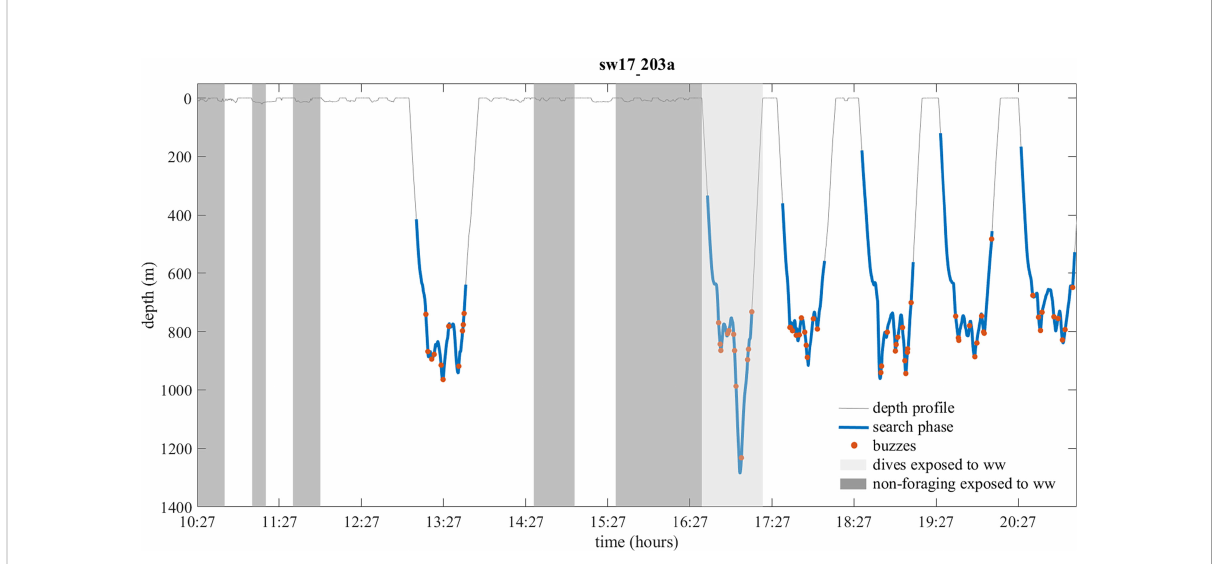
FIGURE 2 Dive pro fi le (thin grey line) of tagged whale sw17_203a with its echolocation behavior (search phase – blue thick segments; buzzes – red circles) superimposed. Dives (light grey shadowing) and non-foraging periods (darker grey shadowing) exposed to whale watching (ww) vessels are